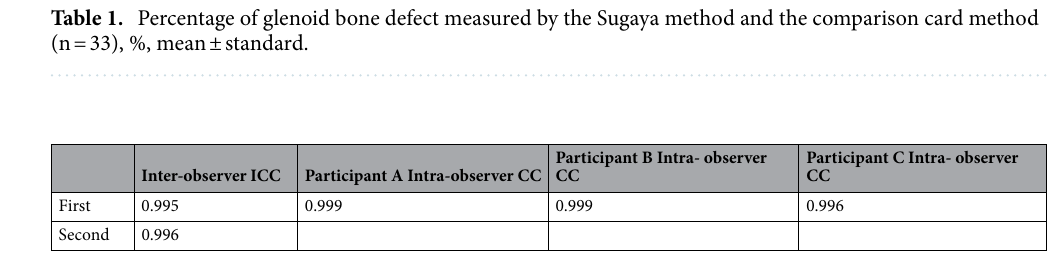
Table 2. Inter- and intra-observer ICC analysis (n = 33).